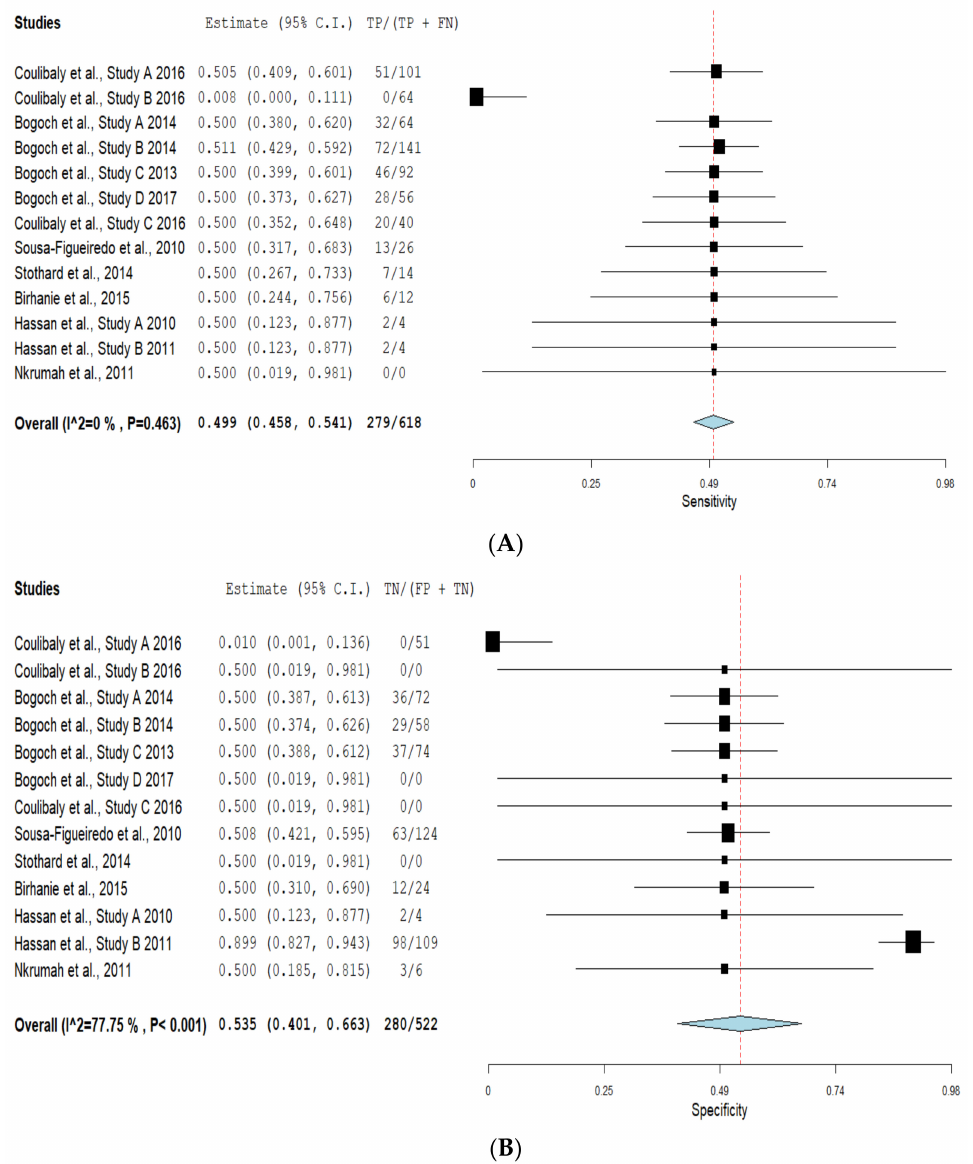
Figure 3. ( A ) Forest plots of pooled sensitivity and specificity estimates for all included studies of mobile-linked diagnostic devices; ( B ) Forest plots of pooled specificity estimates for all included studies of mobile-linked diagnostic